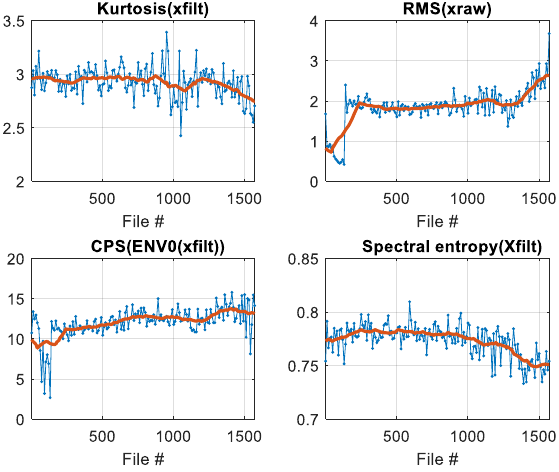
Figure 6. Normalized SES map, i.e., top view of Figure 5—left TB.